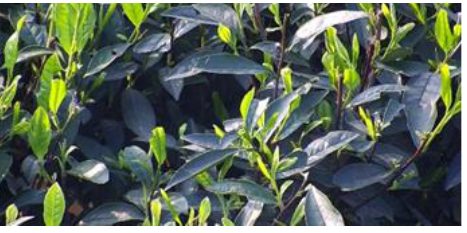
Figure 6. Fuding white tea tree.